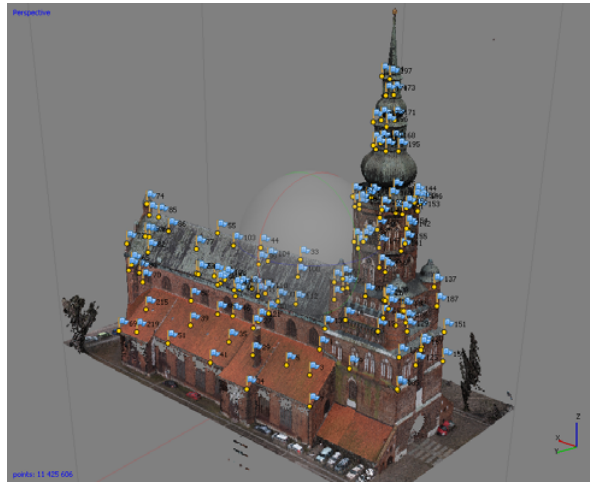
Figure 5. Distribution of the control and check points First, the photogrammetric orientation of 923 images was calculated with Agisoft Photoscan. 117 points measured